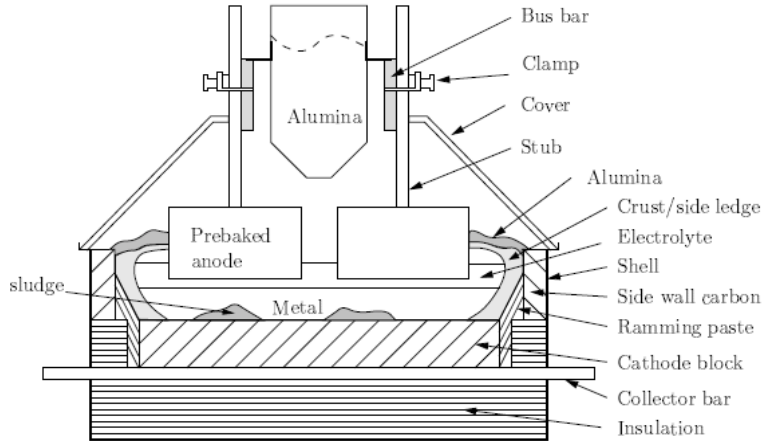
Figure 1. Components of an aluminium electrolysis cell.